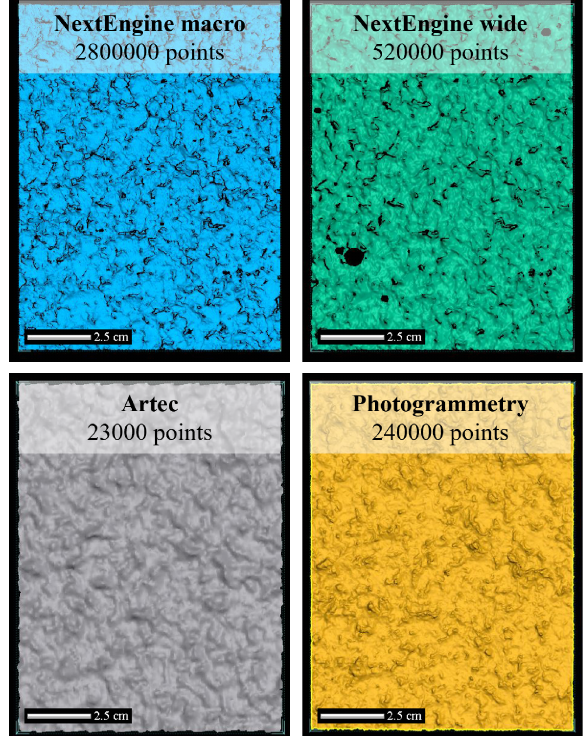
To choose the best surveying techniques for this application, many tests and comparisons were performed.